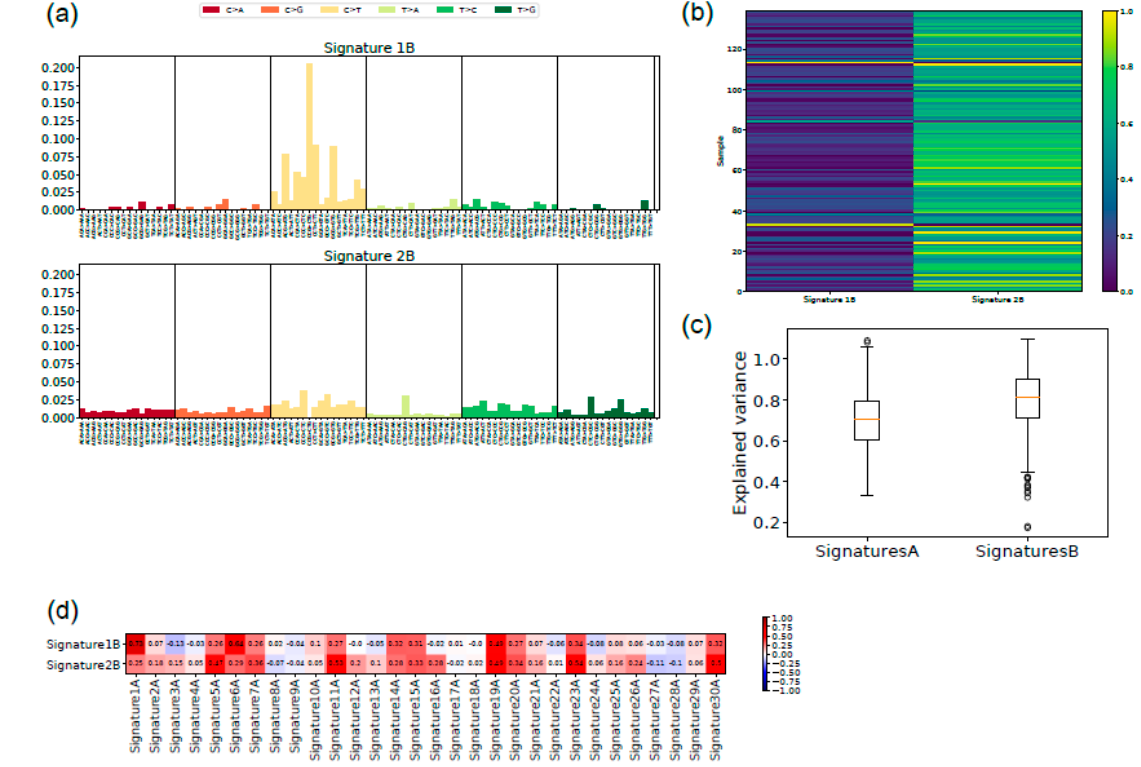
Figure 5. New signatures for uveal melanoma: ( a ) the two signatures with the main exposure for uveal melanoma are shown with the indication of the 96 triplets containing the mutation and the nucleotide 5 ′ and 3 ′ to it; ( b ) the explained variance is shown for Alexandrov’s signatures (A) and the new signatures (B). The lower level of the box indicates the 25th percentile, the upper margin indicates the 75th percentile, the red line indicates the mean; ( c ) the exposure of each single case of uveal melanoma to signatures 1B and 2B is indicated by a color code (0 = completely absent, 1 = perfect match); ( d ) correlation of signatures 1B and 2B with Alexandrov’s signatures. Correlation is indicated by a color code (intense red = 1, intense blue = − 1, white = 0).